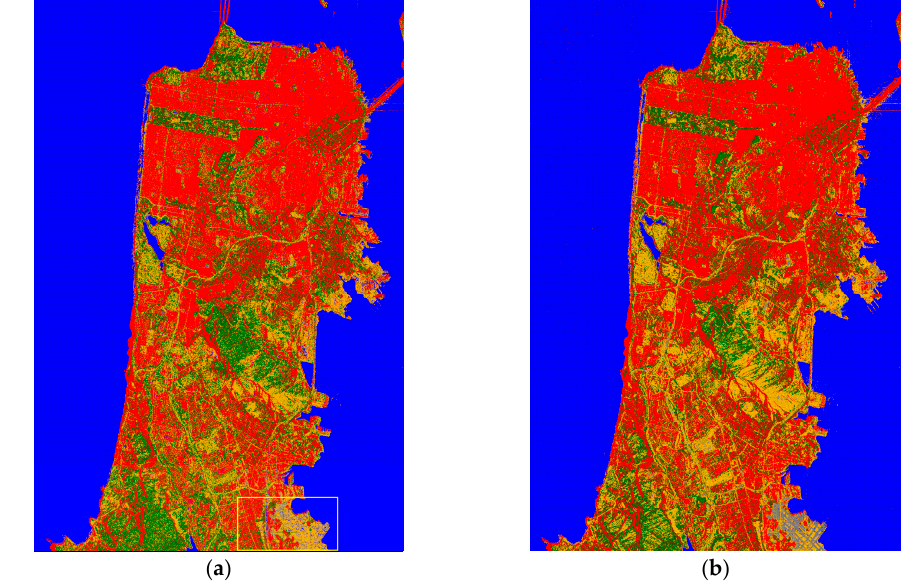
Figure 8. The classification result obtained with ( a ) the Extreme Learning Machine (ELM) and ( b ) Random Forest (RF). The area with yellow boundary in Figure 8a has obvious misclassifications. Table 2. ( A ) shows the classification performance of the Extreme Learning Machine (ELM) and Random Forest (RF); ( B ) exhibits the proportion of selected samples, where the proportion of road samples is low; ( C , D ) show the evaluation of the classification results obtained with ELM and RF in the testing set of selected samples.